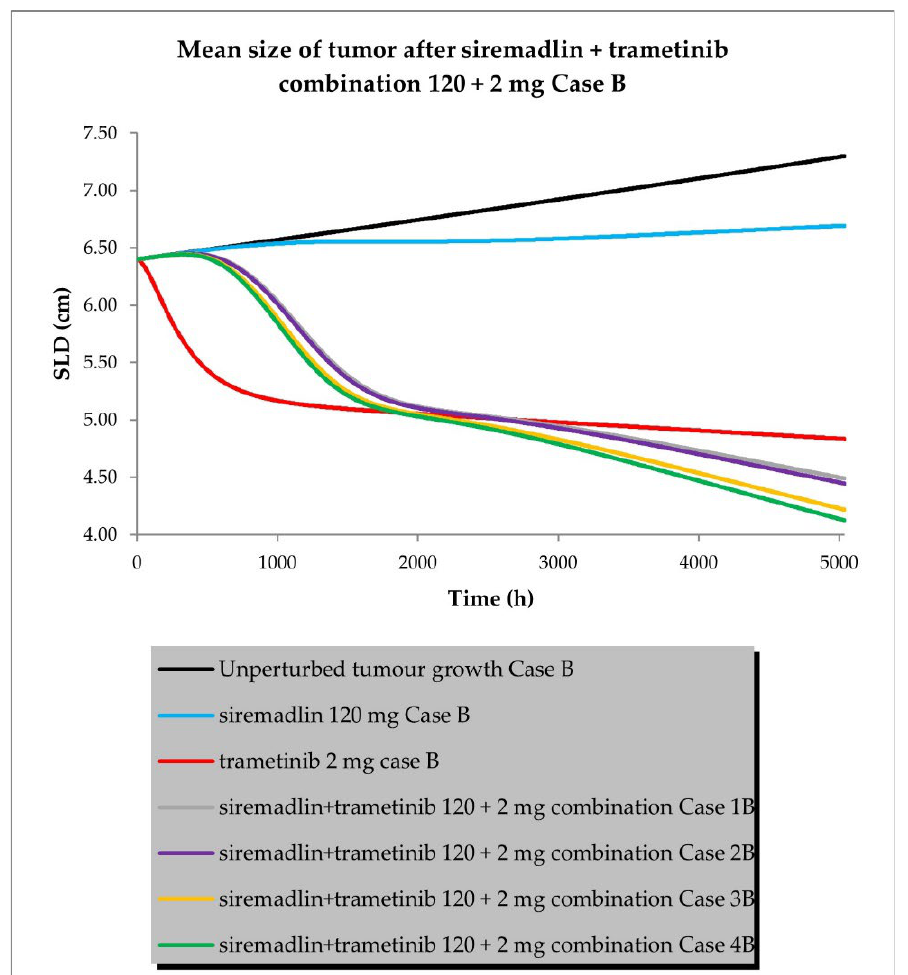
Figure 11. Siremadlin and trametinib combination’s 120 + 2 mg efficacy in population representative of melanoma cancer (Case B—low tumour growth, high initial tumour size, and high fraction of sensitive cells).